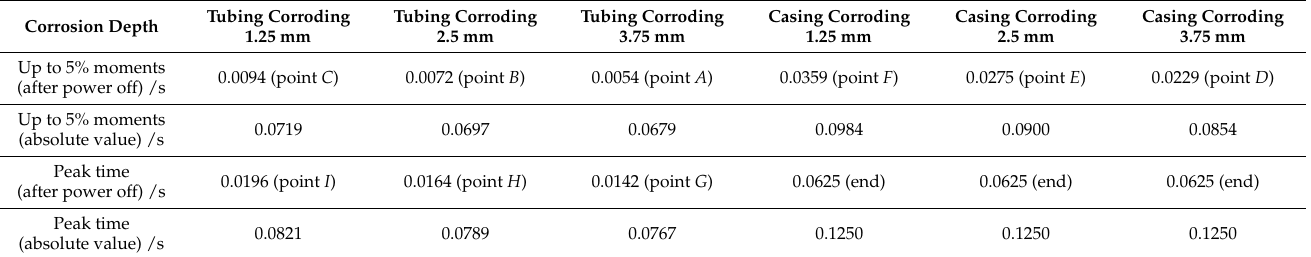
Figure 10. Sensitivity time slice curves for corrosion at different depths in the simulation. Table 1. 5% time and peak time of sensitivity time slice curves for different corrosions in the